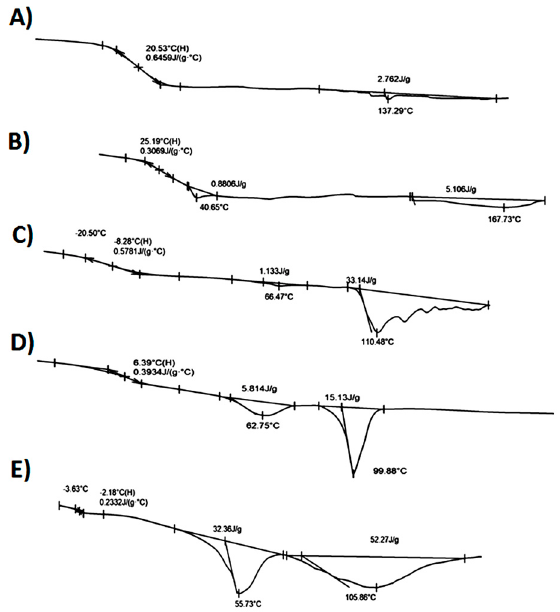
Figure 7. DSC thermograms (second run) of terpolymers; P4 ( A ) before deprotection of hydroxyl and amino groups; ( B ) after deprotection of amino and hydroxyl groups; ( C ) P5 after deprotection of amino and hydroxyl groups; ( D ) P1 after deprotection of hydroxyl groups; ( E ) P8 after deprotection of amino groups.